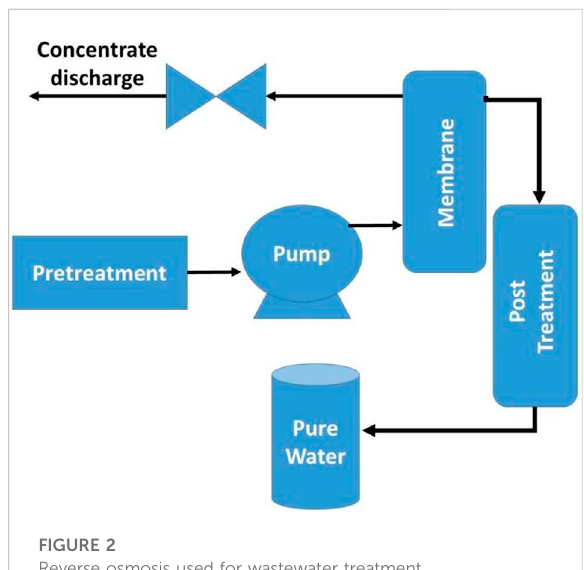
FIGURE 2 Reverse osmosis used for wastewater